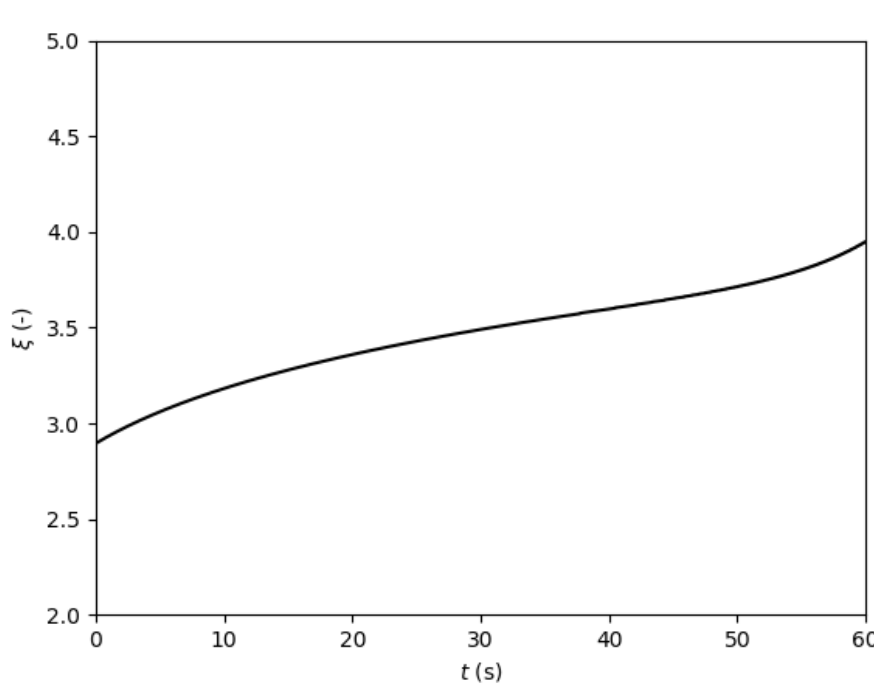
Figure 16. Mixture ratio profile without feedback